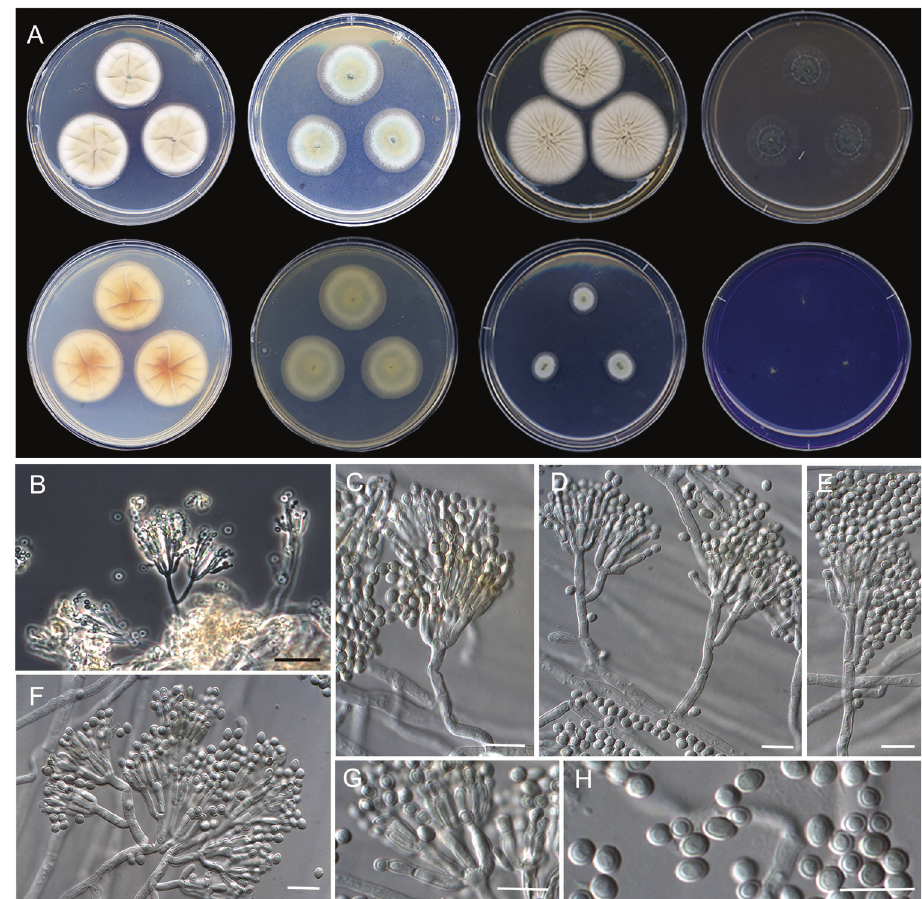
Figure 13. Morphological characters of Penicillium sicoris sp. nov. (ex-type FMR 18076). A colonies from left to right (top row) CYA, MEA, YES, and OA; (bottom row) CYA reverse, MEA reverse, DG18, and CREA B–G conidiophores on MEA H conidia. Scale Bars: 25 μm ( B ), 10 μm ( C–H periphery; soluble pigment absent. On OA, 23–24 mm diam., slightly elevated at center, floccose, grayish green (26E6), opaline green (25C6) and brownish gray (5C2) towards periphery, margins slightly fimbriate, sporulation abundant, conidial masses dull green (27D3); reverse pea green (29D5) at center and brownish gray (5C2) towards periphery; soluble pigment absent. On DG18, 13–16 mm diam., slightly raised at center, velvety, olive (3D3) at center, grayish turquoise (24B3) and white (1A1) towards periphery, margins entire, sporulation abundant, conidial masses grayish turquoise (24B3); reverse, grayish green (1C4) and white (1A1) at periphery; soluble pigment absent. On CREA, 21–27 mm diam., slightly elevated at center, velutinous, apple green (29C7), margins regular, sporulation abundant, conidial masses grayish green (26B3–C3); reverse colorless; soluble pigment absent, acid production absent.